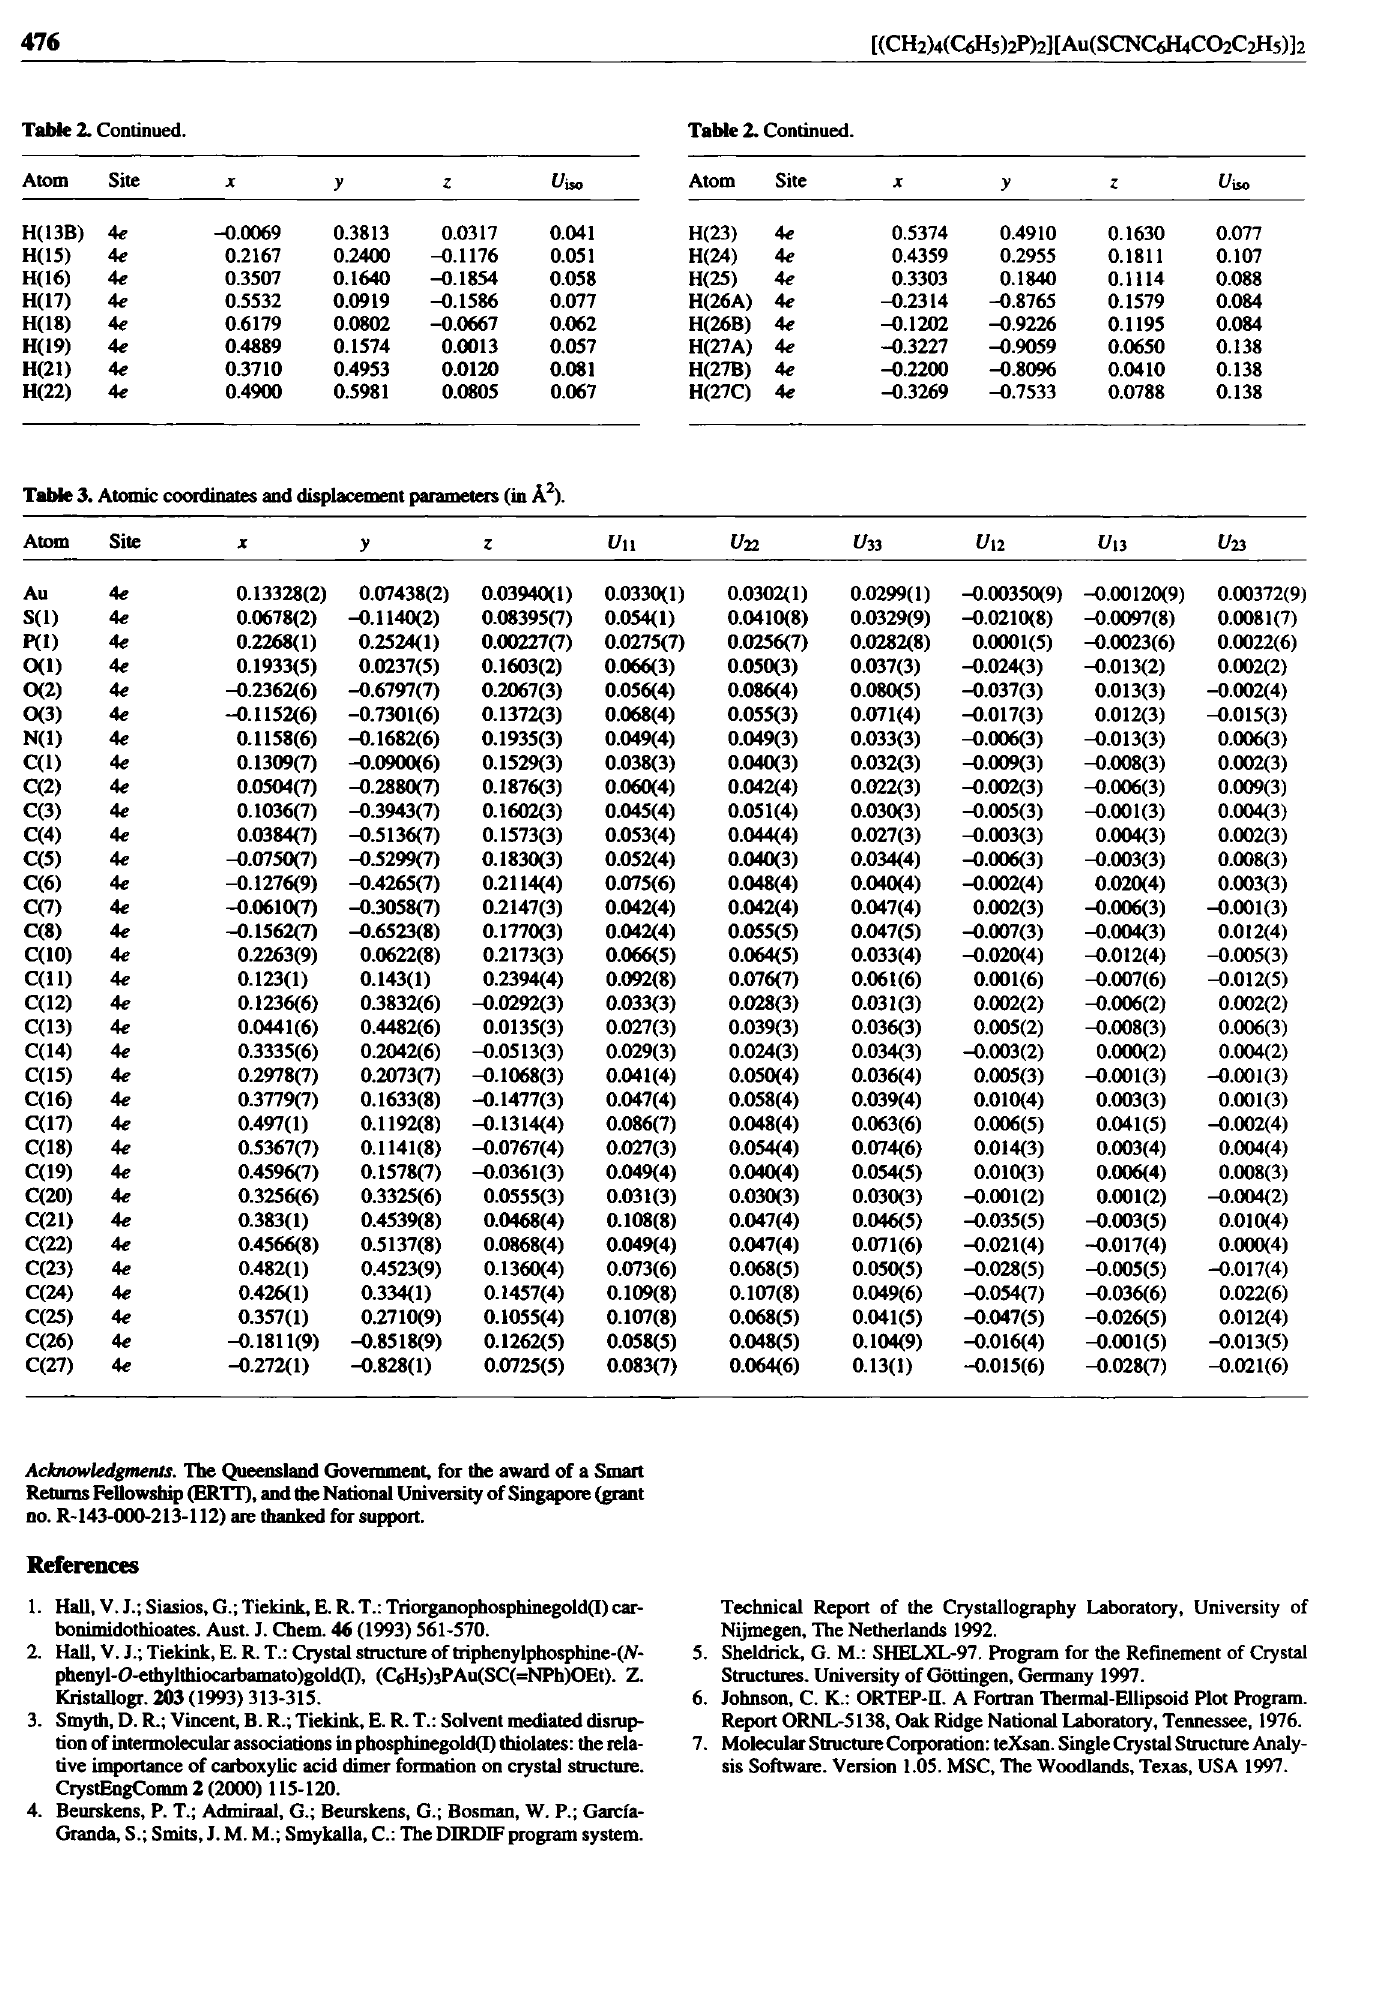
Table 3. Atomic coordinates and displacement parameters (in A 2